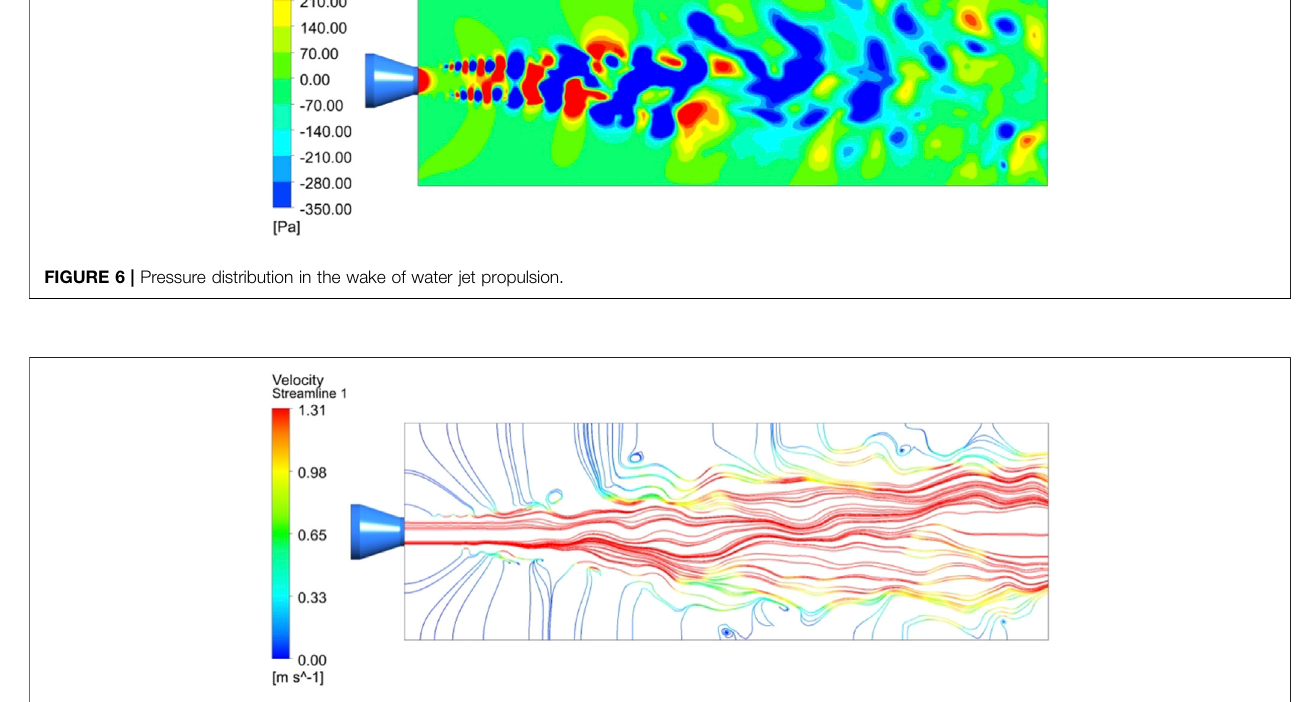
FIGURE 7 | Velocity streamline distribution in the wake area of water jet